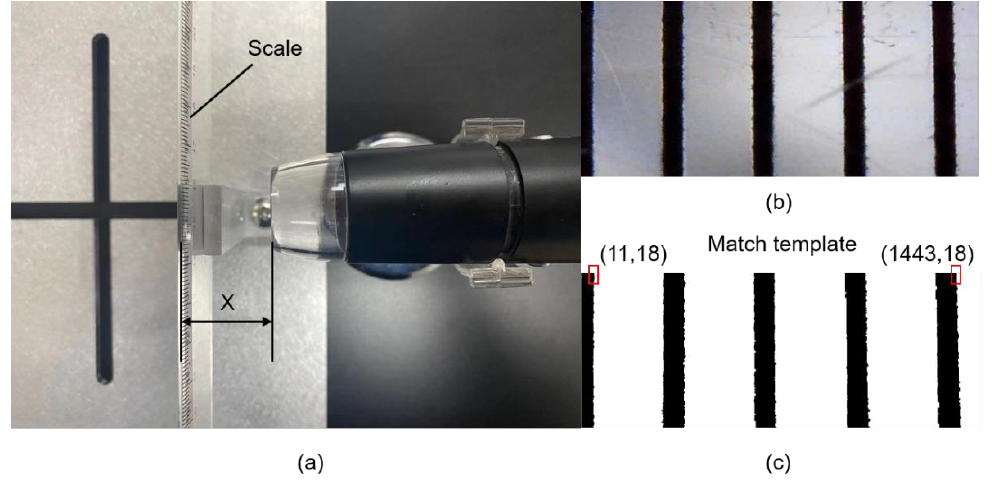
Figure 6. Calibration the actual pixel size. ( a ) The equipment and location for calibration; ( b ) Color image of the scale in the microscope; ( c ) The binarization image of the scale.